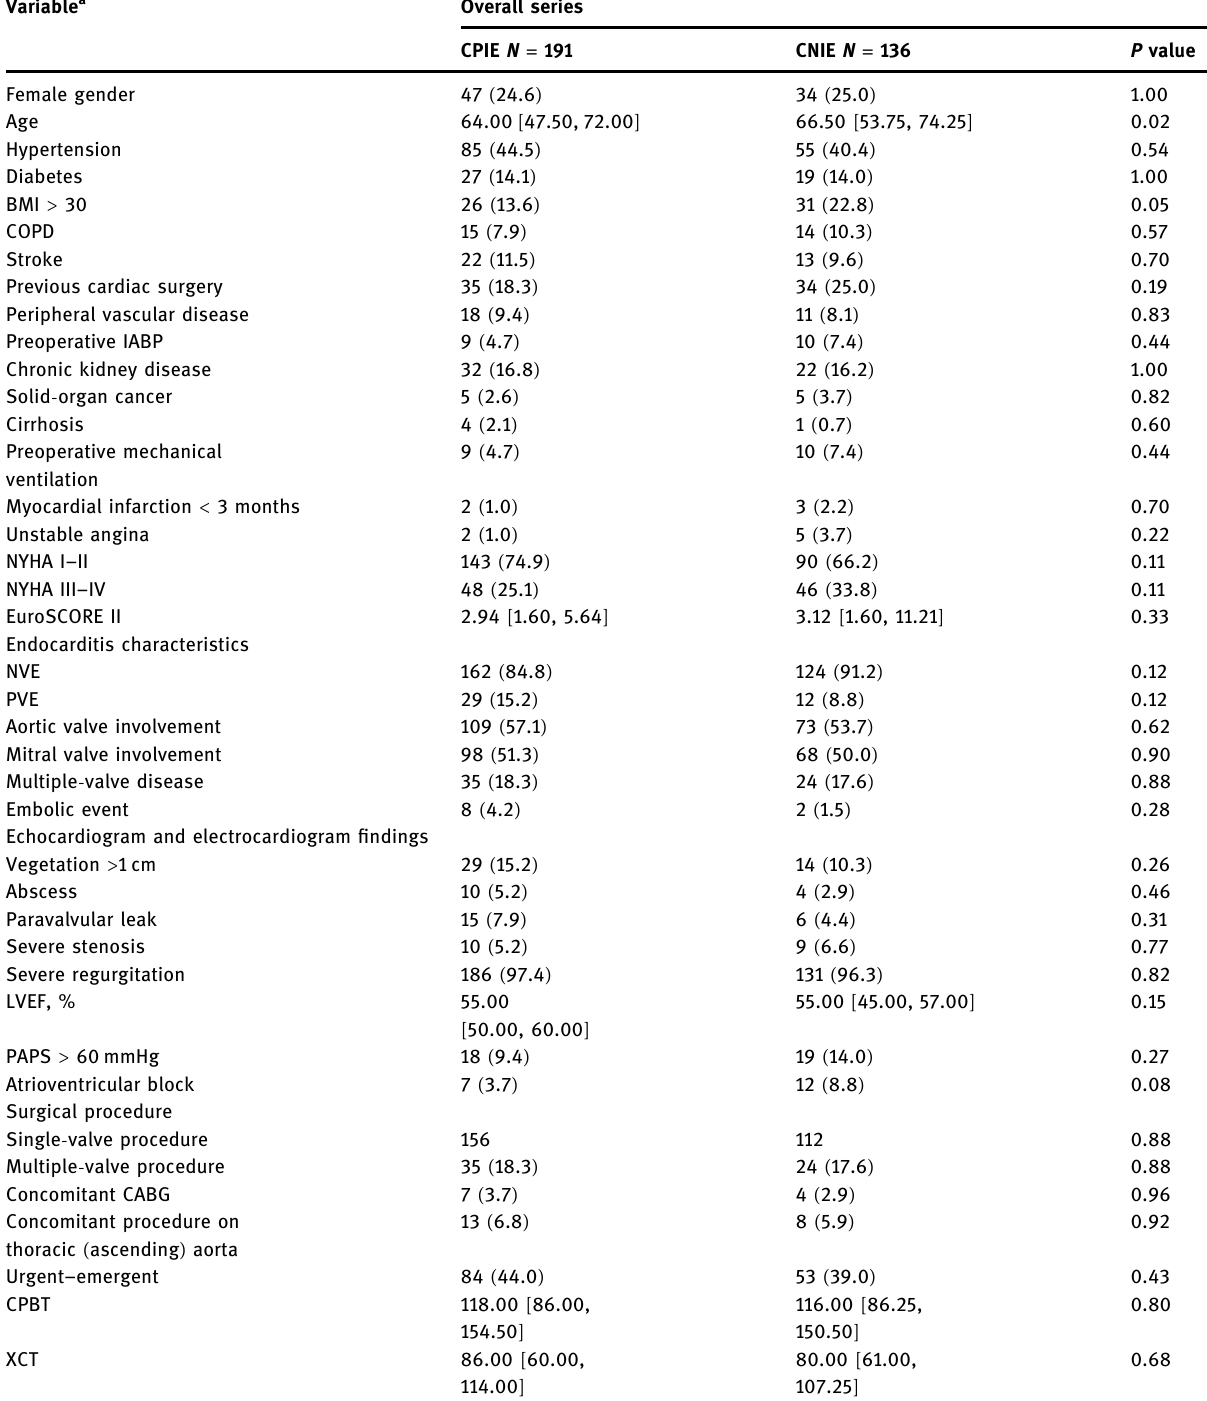
Table 1: Preoperative clinical and operative characteristics of patients with CPIE versus CNIE in the overall series Variable